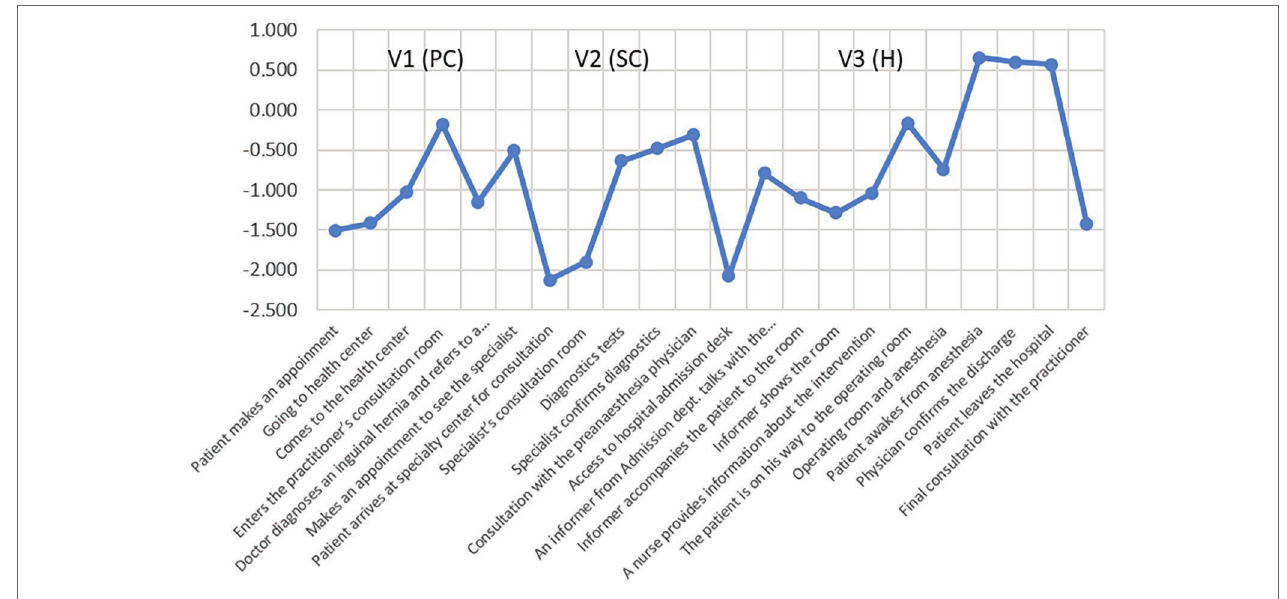
FIGURE 6 | Valence indicator (FEA) through the patient journey.